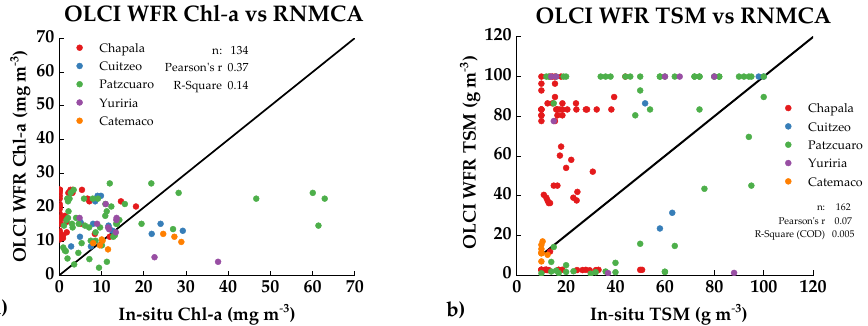
Figure 4. In-situ and S3 derived water quality parameters. ( a ) OLCI WFR Chl-a vs. in-situ measure- ments, ( b ) OLCI WFR tsm_nn vs. in-situ measurements.